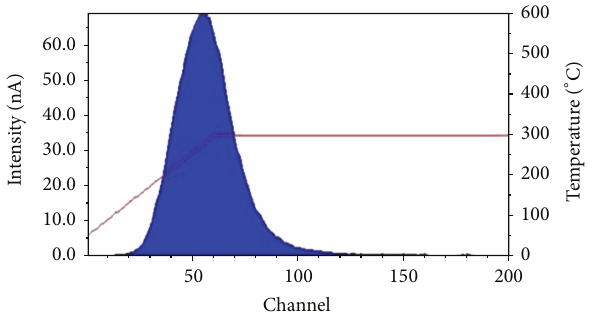
Figure 3: The glow curve for the Cu-doped potassium borate glass following 6MV photon irradiations.